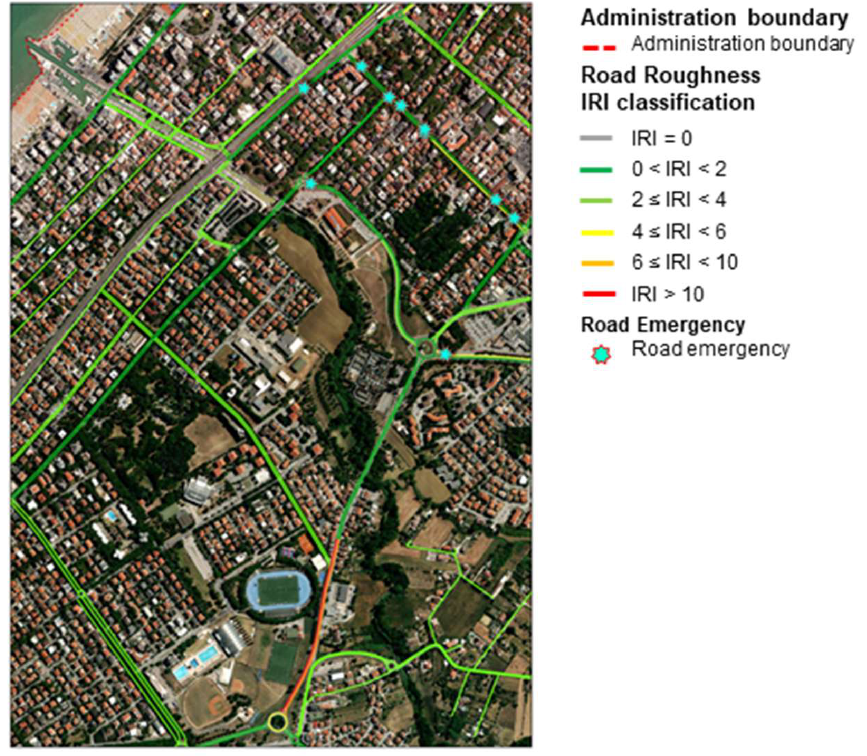
Figure 6. Example of GIS mapping of road pavement roughness (IRI classification) and road emer- gencies.